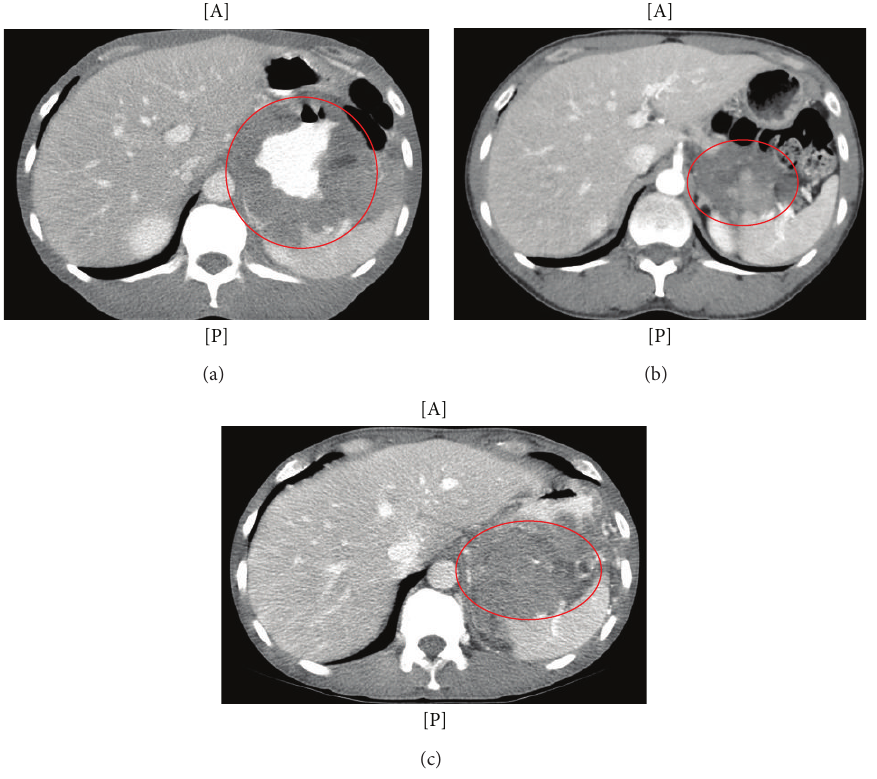
Figure 1: CT scans from three time points showing a gastric mass. (a) Initial presentation. (b) Following 5 months of imatinib therapy. Note tumor response as compared to (a). (c) Following 10 months of imatinib therapy. Note tumor progression (tumor